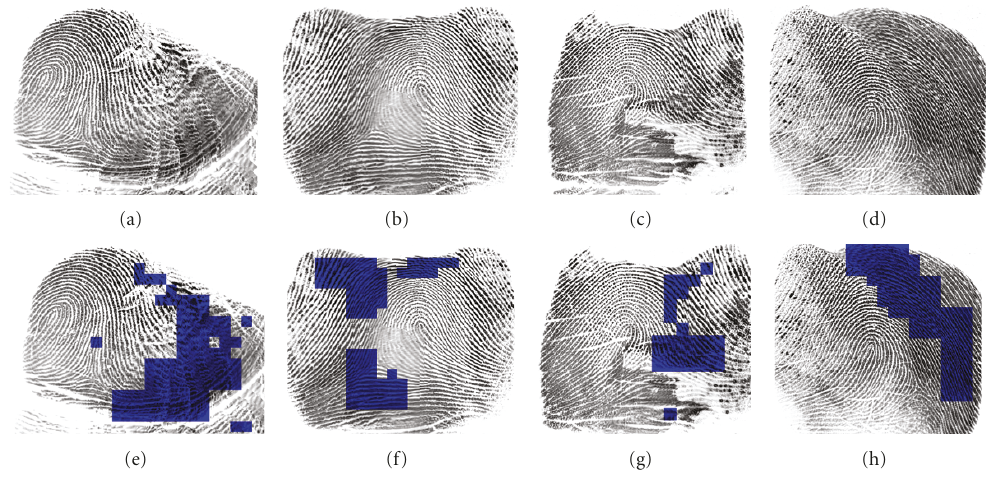
Figure 13: SWT-GLCM-DCT hybrid smear detection